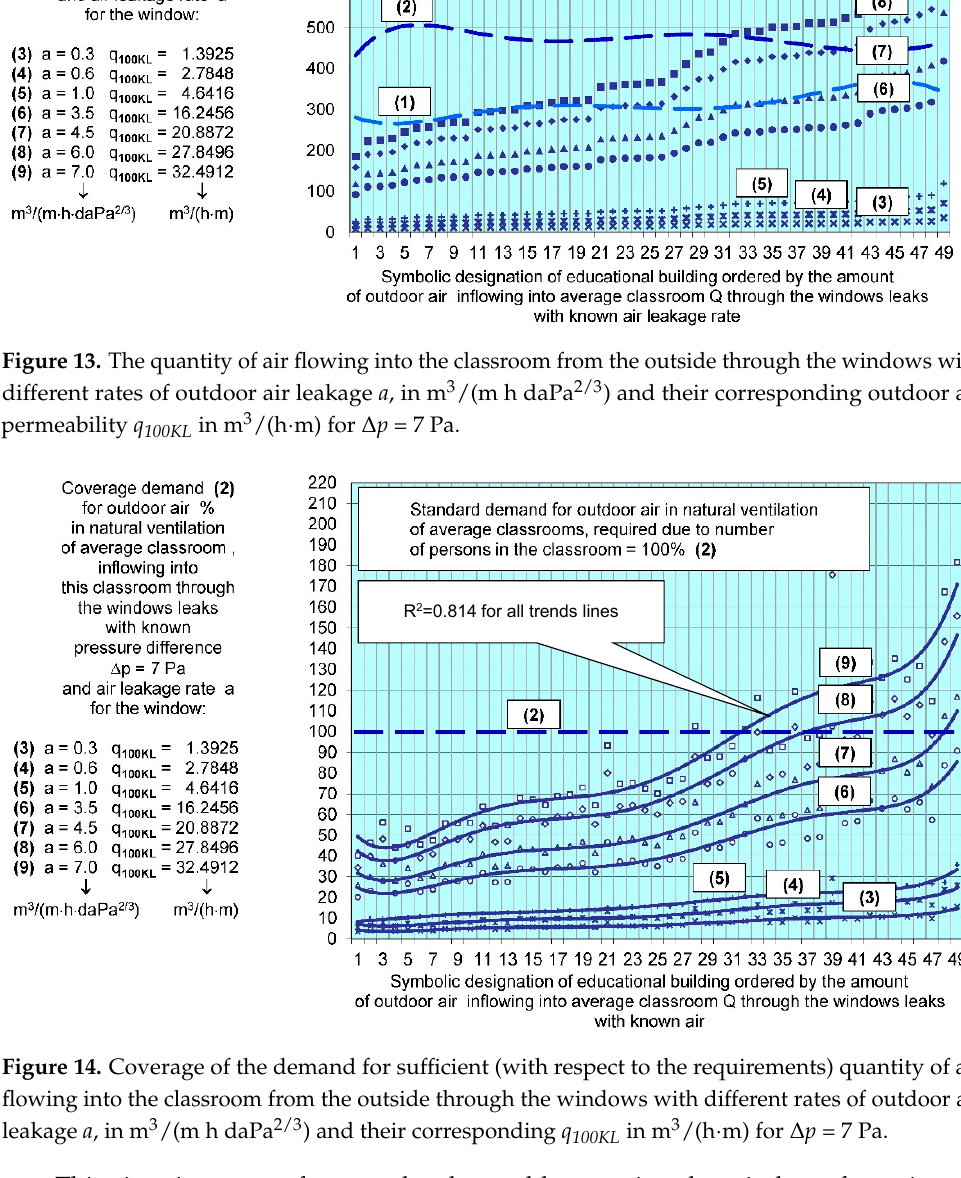
Figure 14. Coverage of the demand for sufficient (with respect to the requirements) quantity of air flowing into the classroom from the outside through the windows with different rates of outdoor air leakage a , in m 3 /(m h daPa 2/3 ) and their corresponding q 100KL in m 3 /(h ⋅ m) for Δ p = 7 Pa.